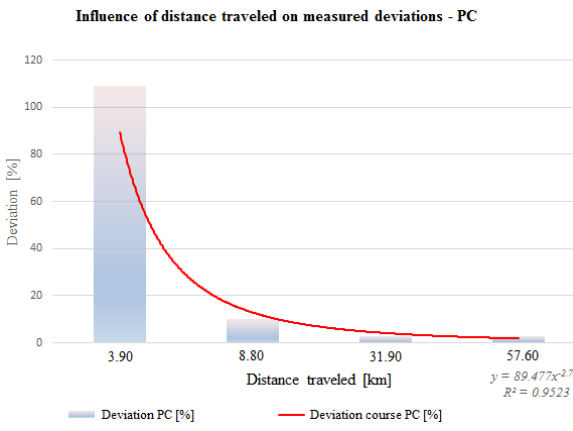
Figure 6: Influence of distance traveled on measured deviations – PC